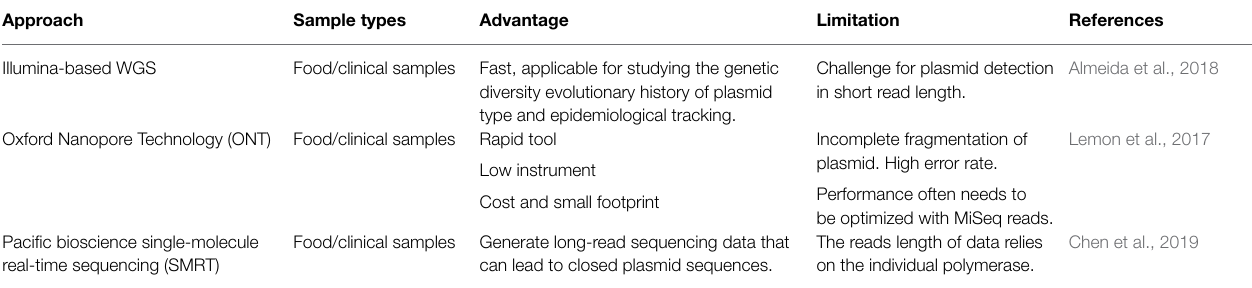
TABLE 1 | Approaches to detect plasmid-based antimicrobial resistance (AMR) genes.